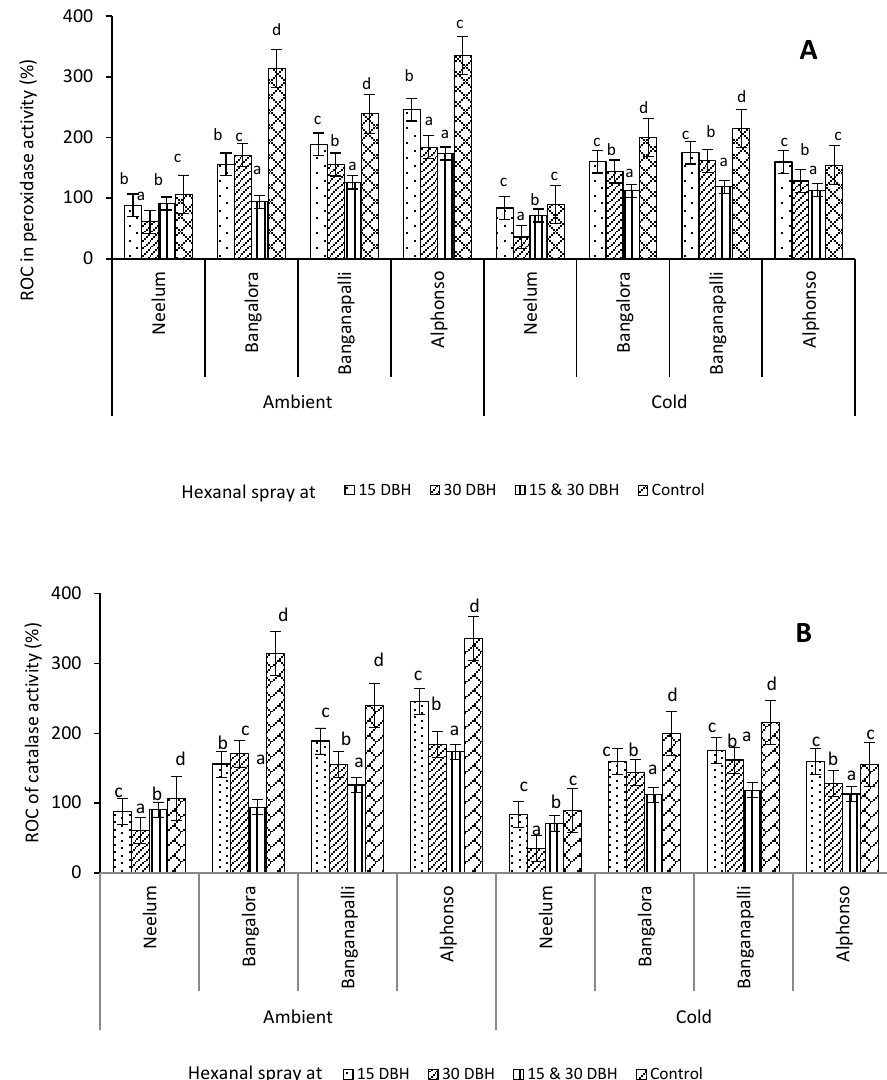
Figure 8. Percentage rate of change in the peroxidase ( A ) and catalase activity ( B ) of the hexanal- treated and control mango fruits stored under ambient and cold conditions. The vertical bars in columns represent the standard error of four replicates. Columns with different and same letters indicate statistical significance and non-significance, respectively ( p = 0.05). DBH — Days before harvest; ROC — Rate of change.